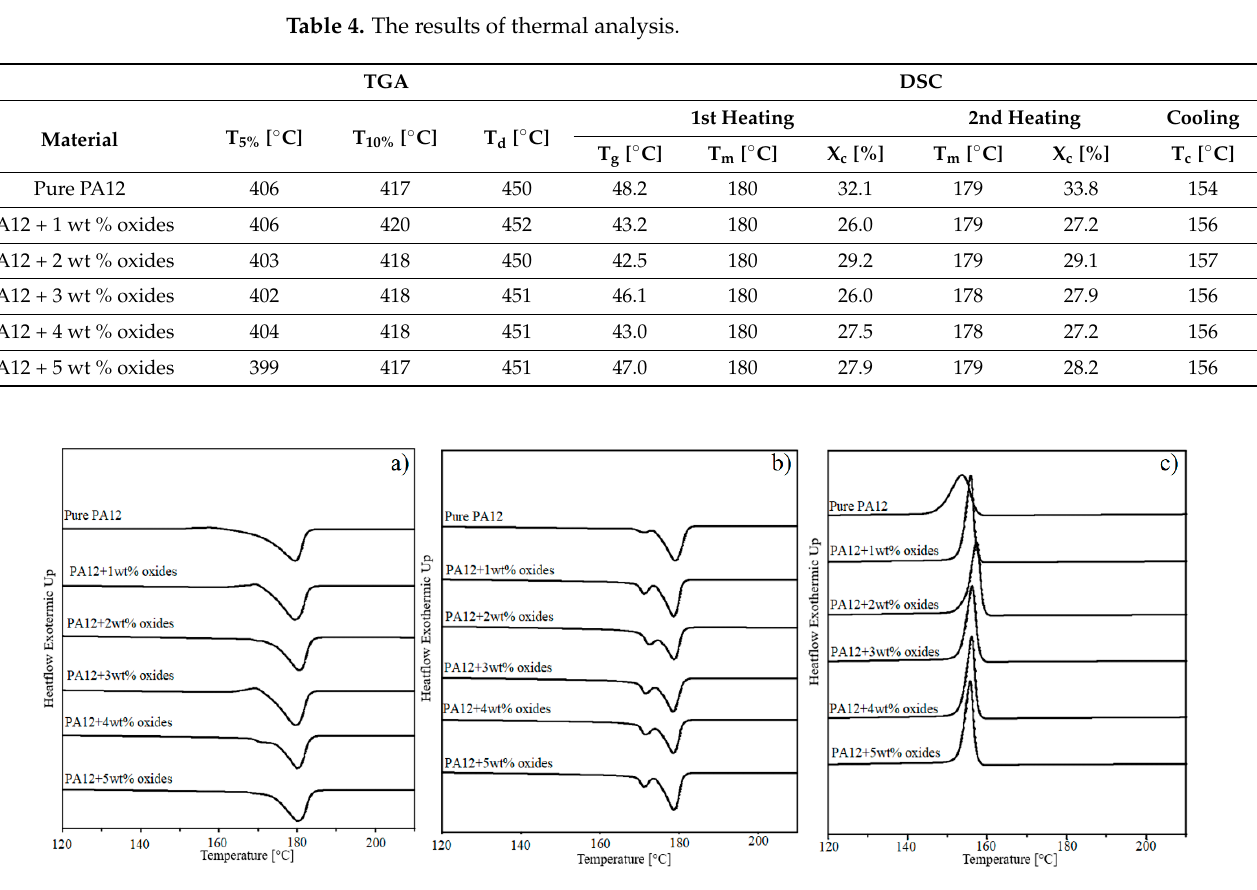
Table 4. The results of thermal analysis.